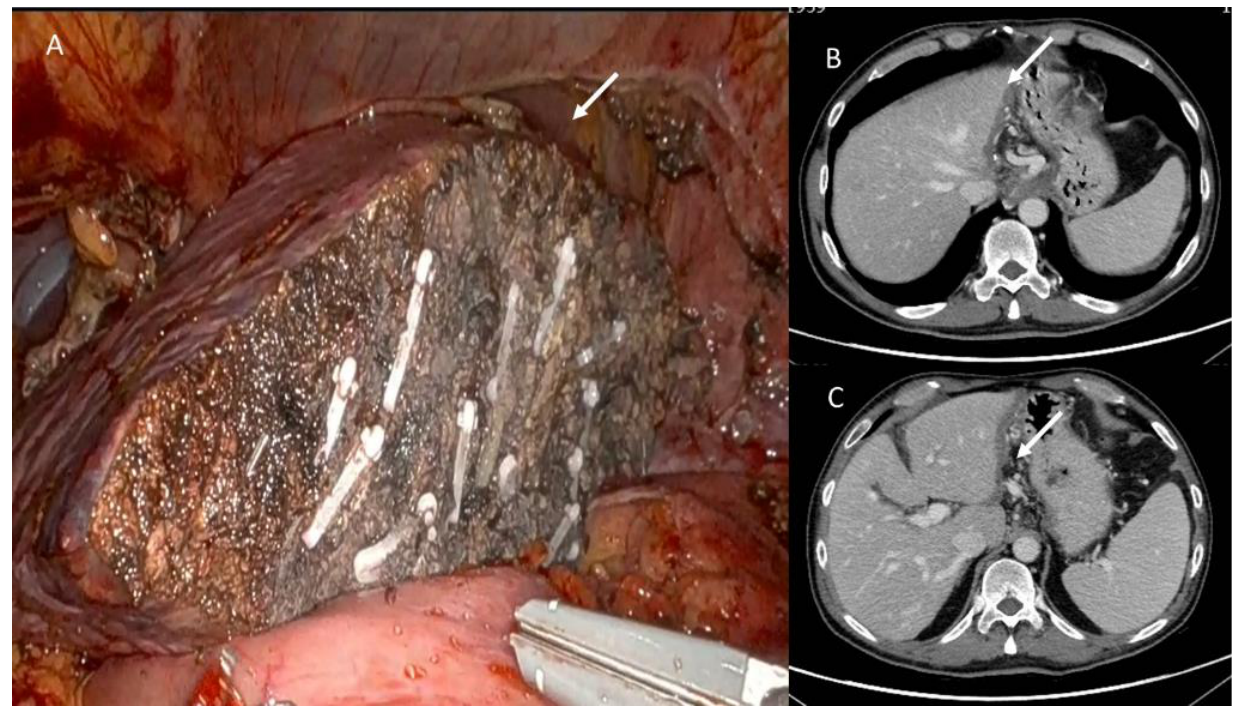
Figure 8. in ( A , B ) robotic atypical resection of lesion located in segment VIII. In ( C – E ), CT evalua- tion: arrows show fluid collection.